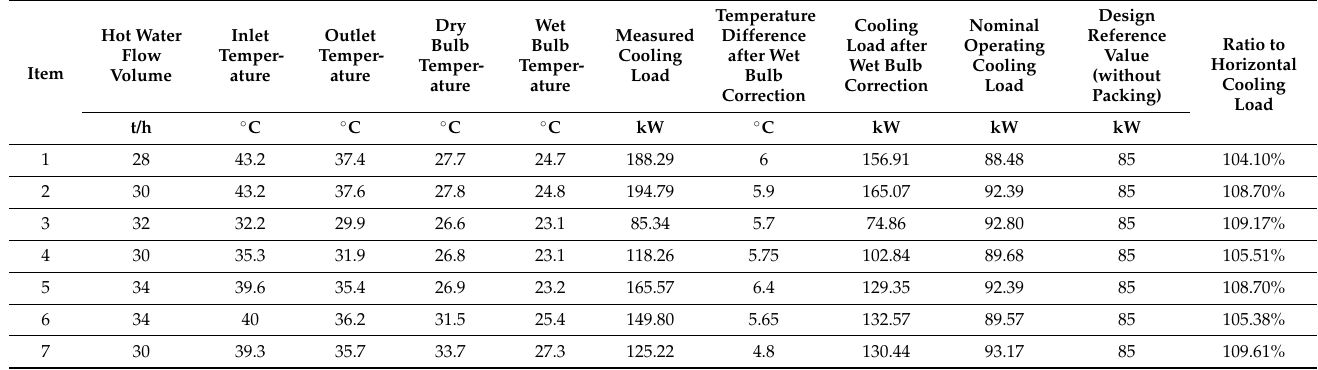
Table 2. Comparison between the vertical CECT cooling-load tested value and its conversion to the nominal working-condition under different working conditions.